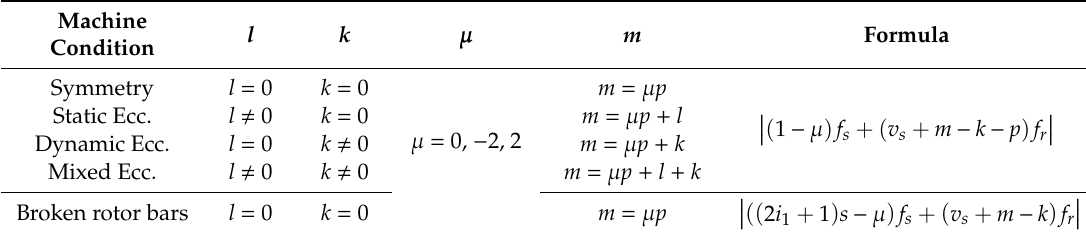
Figure 6. Measurement circuit for the zero-sequence voltage component.